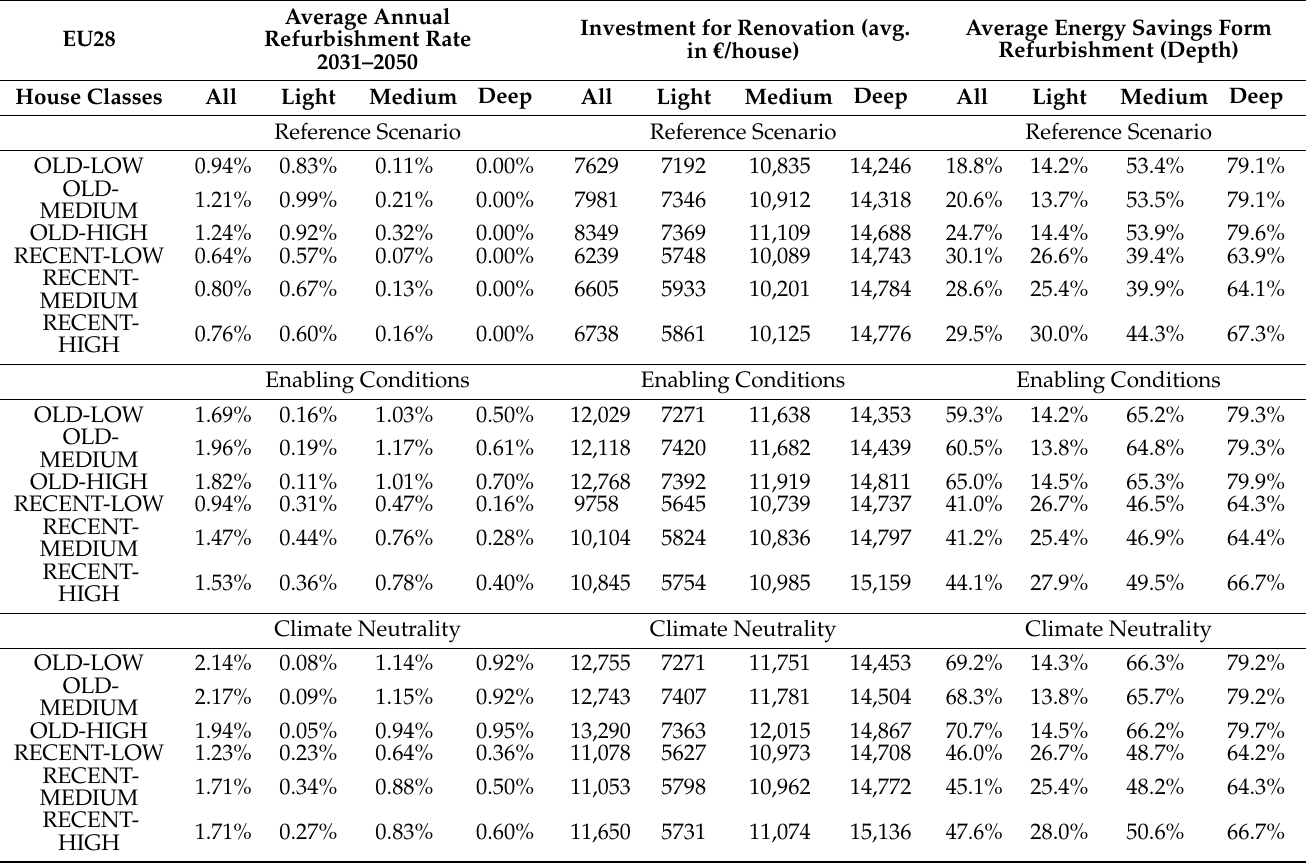
Table 6. Summary of model results for house renovation split by renovation depth level and house or consumer